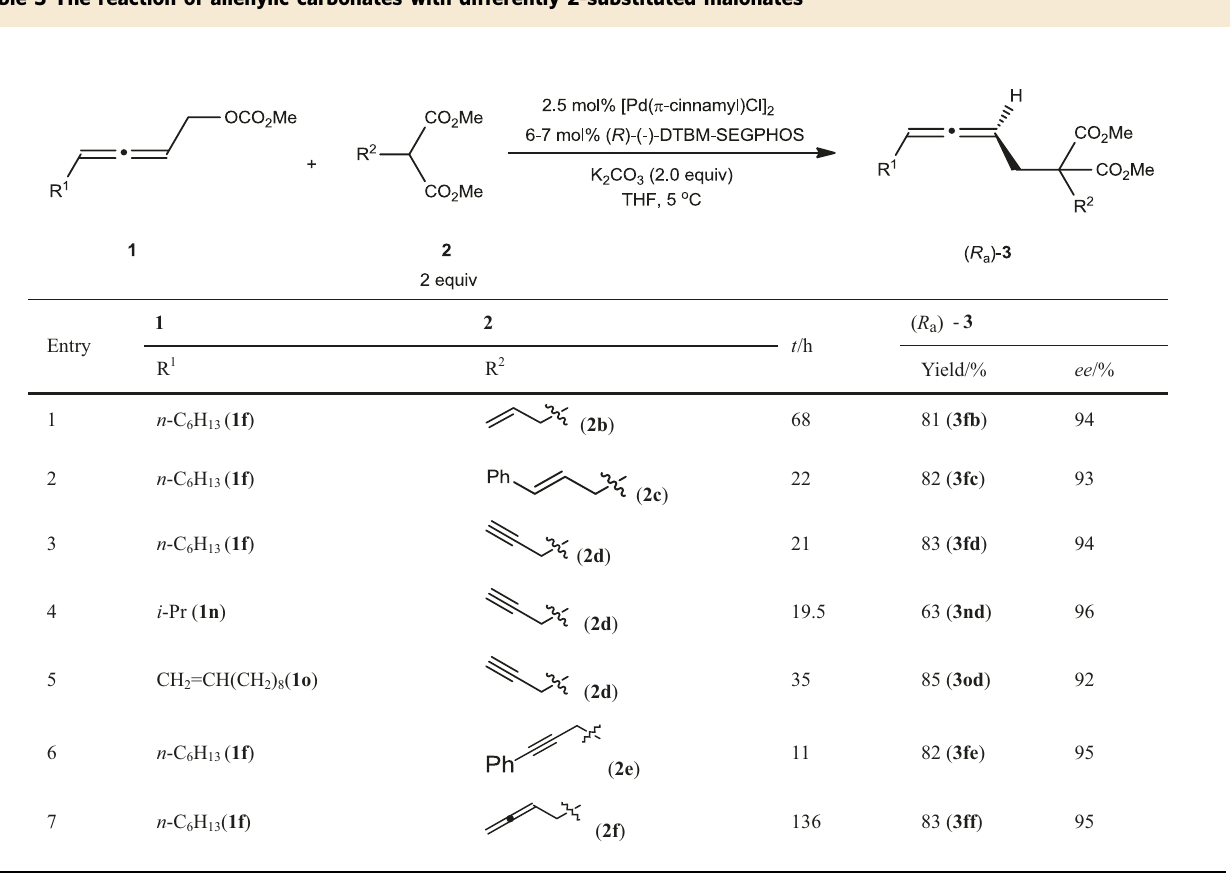
Table 3 The reaction of allenylic carbonates with differently 2-substituted malonates